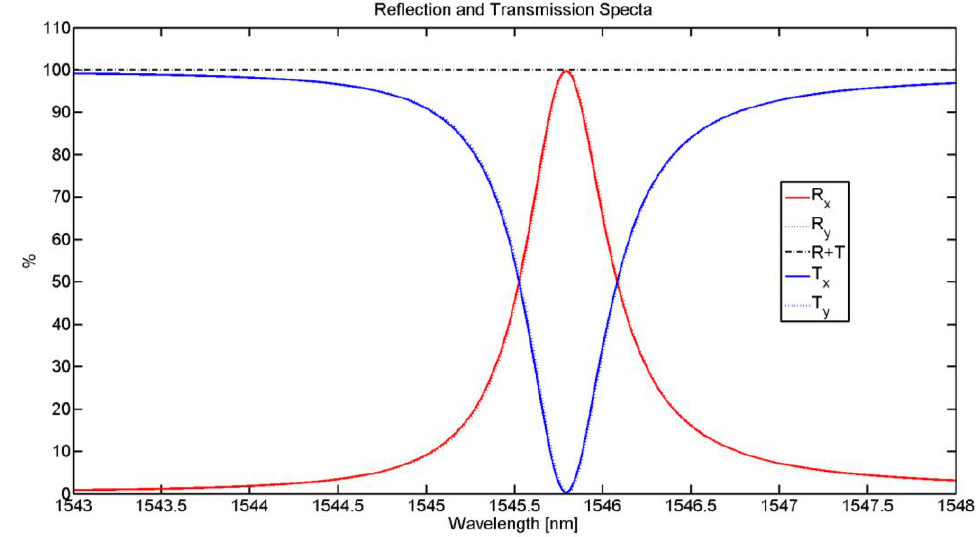
Figure 3. RCWA results of a fixed period and duty-cycle GMRF. The R and T ) represent the reflection (and transmission) spectra from the polarizations in the y x and y